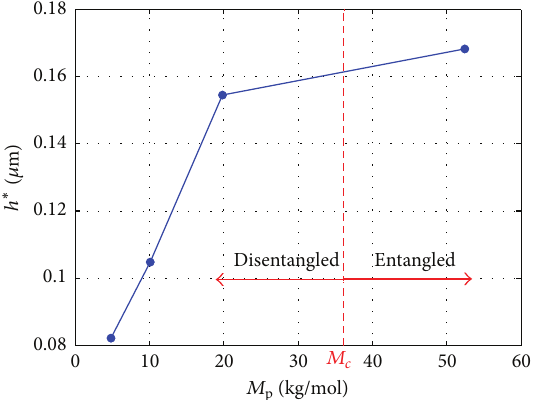
Figure 22: The length scale parameter ℎ ∗ of (10) for PS with molecular weights of 4920, 10050, 19880, and 52220 g/mol [58].